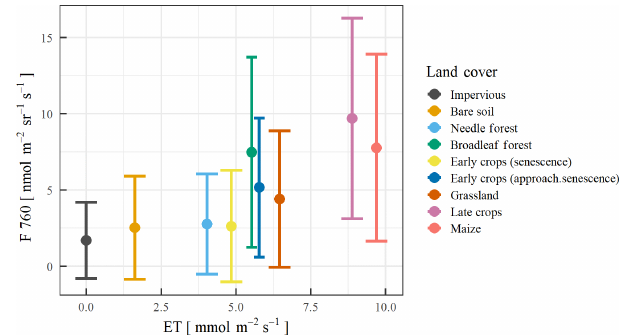
Figure 15. Relation between evapotranspiration (ET) and fluores- cence F 760 , including the standard deviation for the nine land use categories defined in Table 4. The data were collected on 26 June